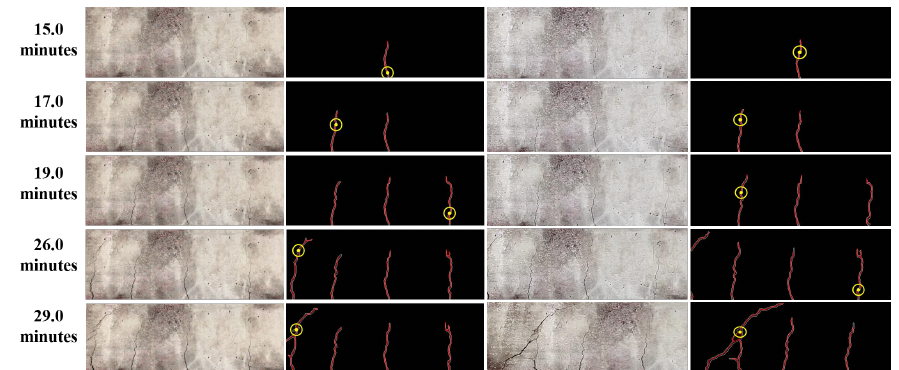
Figure 10. Snapshots of the original transformed images of the concrete surface and its corresponding detected cracks using the proposed framework at various instants of time with position of maximum crack width shown as yellow circle. The first and second column corresponds to video captured using iPhone, whereas the third and fourth columns corresponds to video captured using UAV.